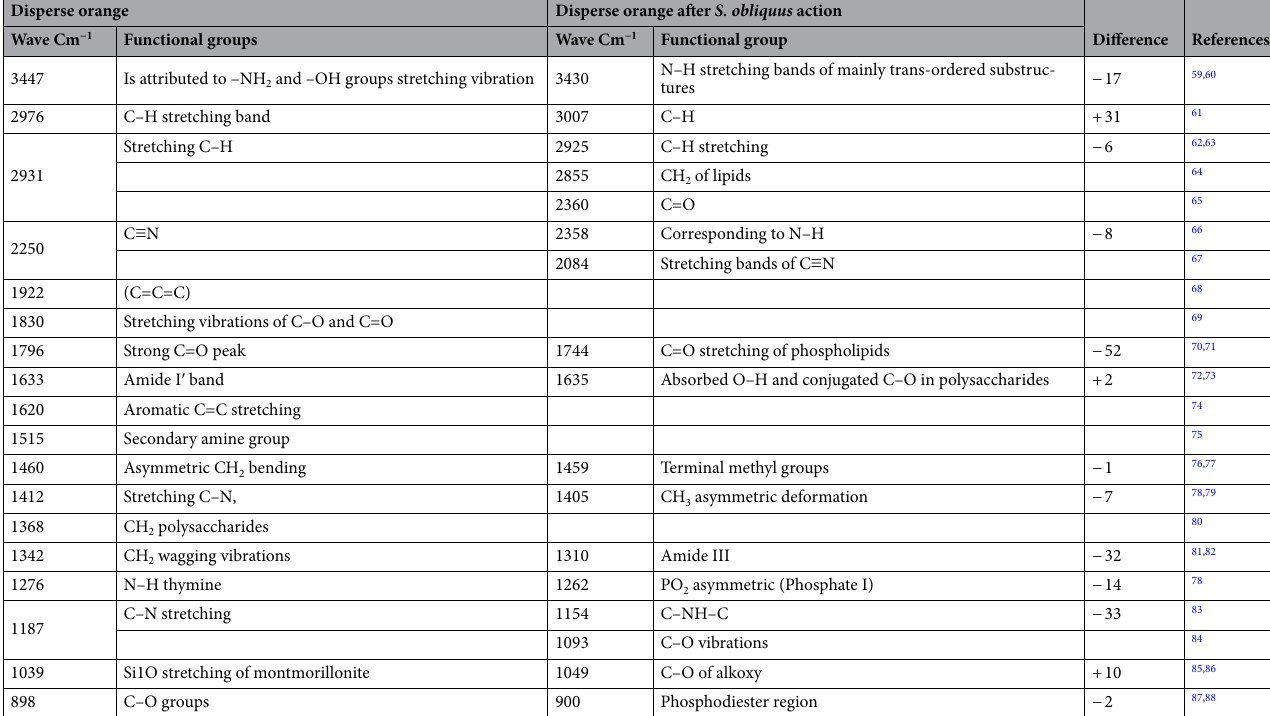
Table 1. Infrared spectrum of Disperse orange before S. obliquus action and Infrared spectrum of Disperse orange after S. obliquus